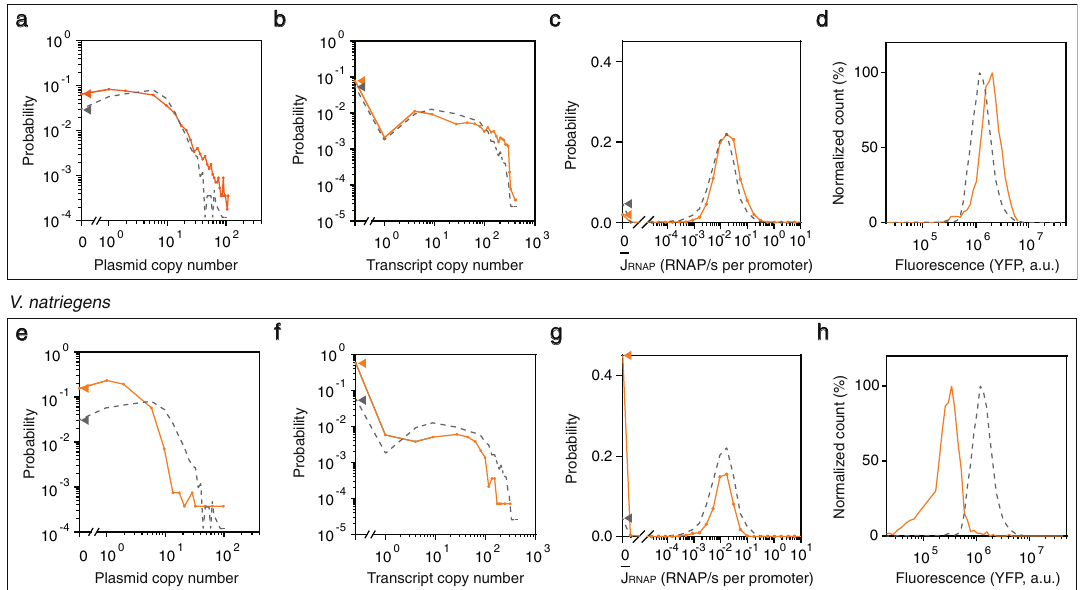
Fig. 3 Calculation of plasmid copy number and promoter activity across different strains. The dashed lines in all graphs are the distributions for E. coli NEB 10-beta. a Plasmid copy number ( n = 1449, p -values from the two-sample Kolmogorov – Smirnov test for pooling the replicates are 0.26/0.92/0.43). b mRNA copy number ( p = 0.38/0.99/0.69). c Promoter activites of P J23101 . d The YFP fl uorescence distribution. e Plasmid distribution for V. natriegens ( n = 783, p = 0.55/0.05/0.77). f mRNA copy number ( p = 0.25/0.35/0.62). g Promoter activites of P J23101 . h The YFP fl uorescence distribution. All the distributions are made from a combination of three replicates performed on different days. For part a , b , c , e , f and g , dots are experimental data with lines to guide the eye. For part a , b , e and f , the triangles indicate the percent of cells where no plasmid or transcript is detected. For part c and g , the triangles indicate the percent of cells where no promoter activity is detected, but where plasmid can be observed. Source data are provided as a Source Data fi